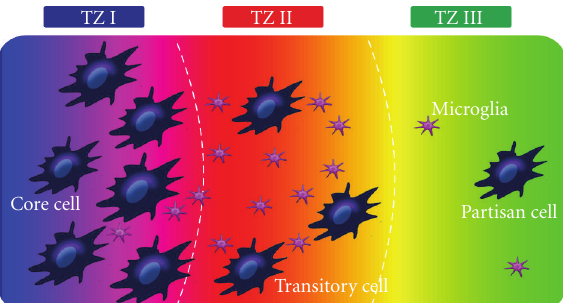
Figure 5: The brain tumor microenvironment, heterogeneous tumor zones and MIF actions. Conceptual framework depicting the metabolic and immune cell complexity of malignant brain tumors, (glioblastomas, GBM) is given as a simplified model classifying the tumor into three distinct tumor zones (TZ1–TZ3). Tumor Zone 1 (TZ1) consists of the main tumor—bulk and core glioma cells, corresponding to contrast enhancing regions in MRI images. MIF is mainly produced in TZ1 and secreted into the extracellular space. TZ2 represents the area of perifocal edema, which is characterized by its specific proangiogenic microenvironment and presence of transitory glioma cells. In addition, this tumor zone shows pronounced accumulation of microglial cells, which also infiltrate TZ1. TZ3 is the most awkward zone for therapeutic intervention, since this tumor zone consists mainly of healthy brain parenchyma. However, isolated glioma-initiating cells termed partisan cells colonize TZ3 and are most probably responsible for tumor recurrence following surgery. TZ2 is probably biologically most active, influencing TZ1 and TZ3 by tumor-derived metabolites impacting the immune system, angiogenesis, and cell